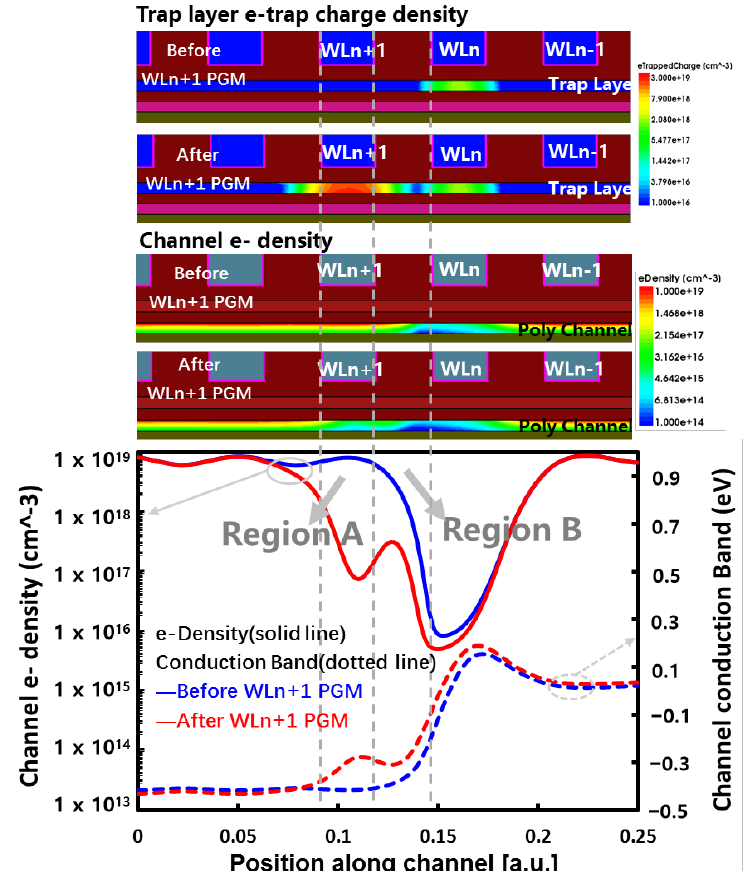
Figure 2. The z-interference simulation principal analysis.